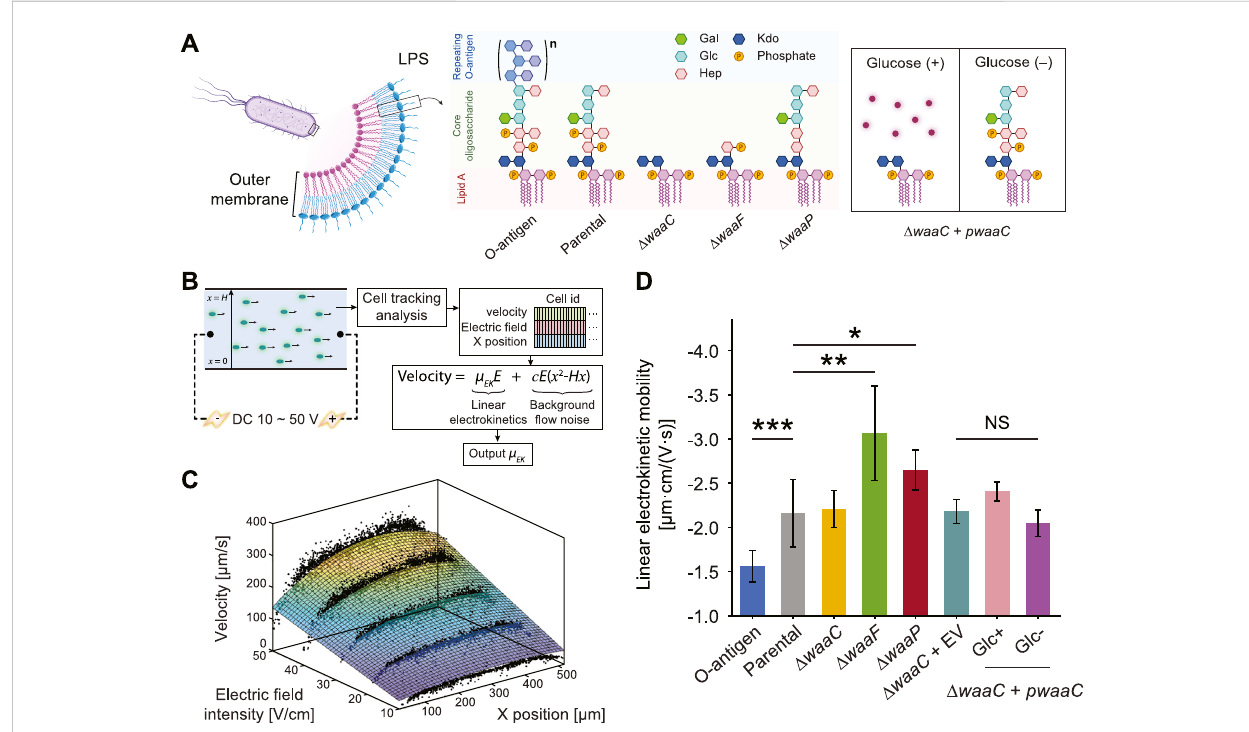
FIGURE 1 Truncating E. coli LPS core components affects cell electrokinetic mobility. (A) Schematic of the expected LPS structures of E. coli strains examined in this study. The O-antigen expressing strain is a K-12 strain with restored O16 polysaccharide synthesis. The parental strain expresses full-length LPS without O-antigen. Δ waaC and Δ waaF mutants exhibit a shorter LPS, leaving only the Kdo 2 -lipid A and Hep-Kdo 2 -lipid A moieties of the inner core, respectively. The Δ waaP strain lacks phosphoryl substituents on heptose (Hep) residues I and II, and is de fi cient in adding heptose III. The waaC - complementarystrain( Δ waaC + pwaaC )carriestheplasmidpCH450- waaC ,whoseexpressionissuppressedinthepresenceofglucose(Halvorsenetal., 2021).Abbreviations:Kdo,3-deoxy-D- manno -oct-2-ulosonicacid;Hep, L -glycero- D - manno -heptose;Glc,glucose;Gal,galactose. (B) Work fl owofthe cell tracking analysis for measuring cell linear electrokinetic mobility. Cell motion in a straight PMMA channel was imaged to extract cell velocity, x position, and corresponding electric fi eld, which were then used to derive linear electrokinetic mobilities ( μ EK ) for individual cells. A 3D fi tting model was